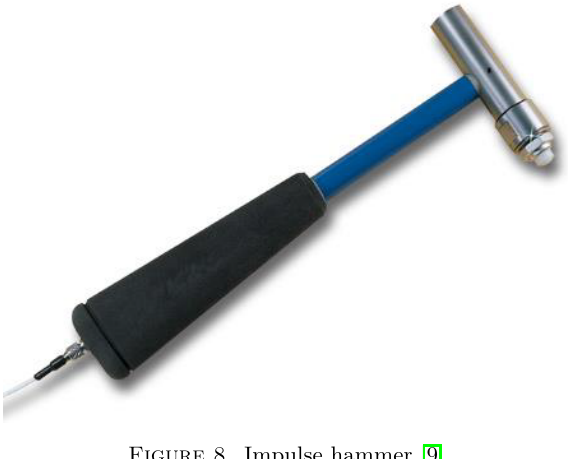
Figure 8. Impulse hammer [9].